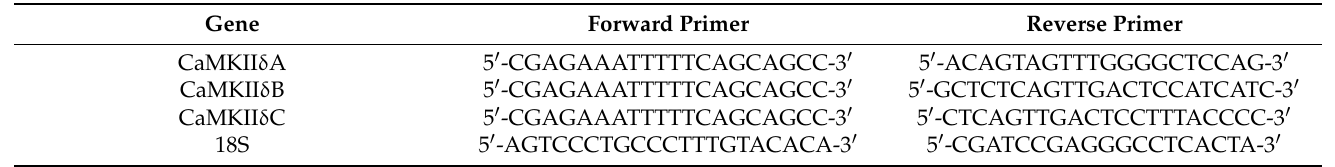
Table 1. The sequences of the primers for real-time